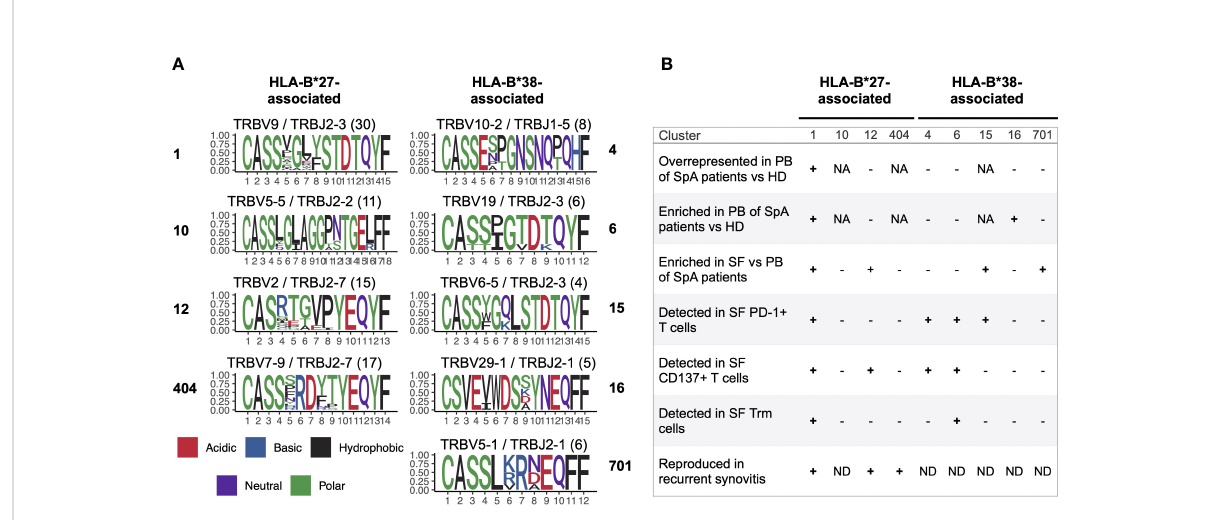
FIGURE 3 Characteristics of identi fi ed TCRbeta clusters. Sequence logo of CDR3 regions (A) and details (B) of the 9 identi fi ed clusters associated with HLA-B*27 or HLA-B*38. Values in parentheses represent the number of distinct clonotypes. PB, peripheral blood; SF, synovial fl uid; NA, not applicable; ND, no